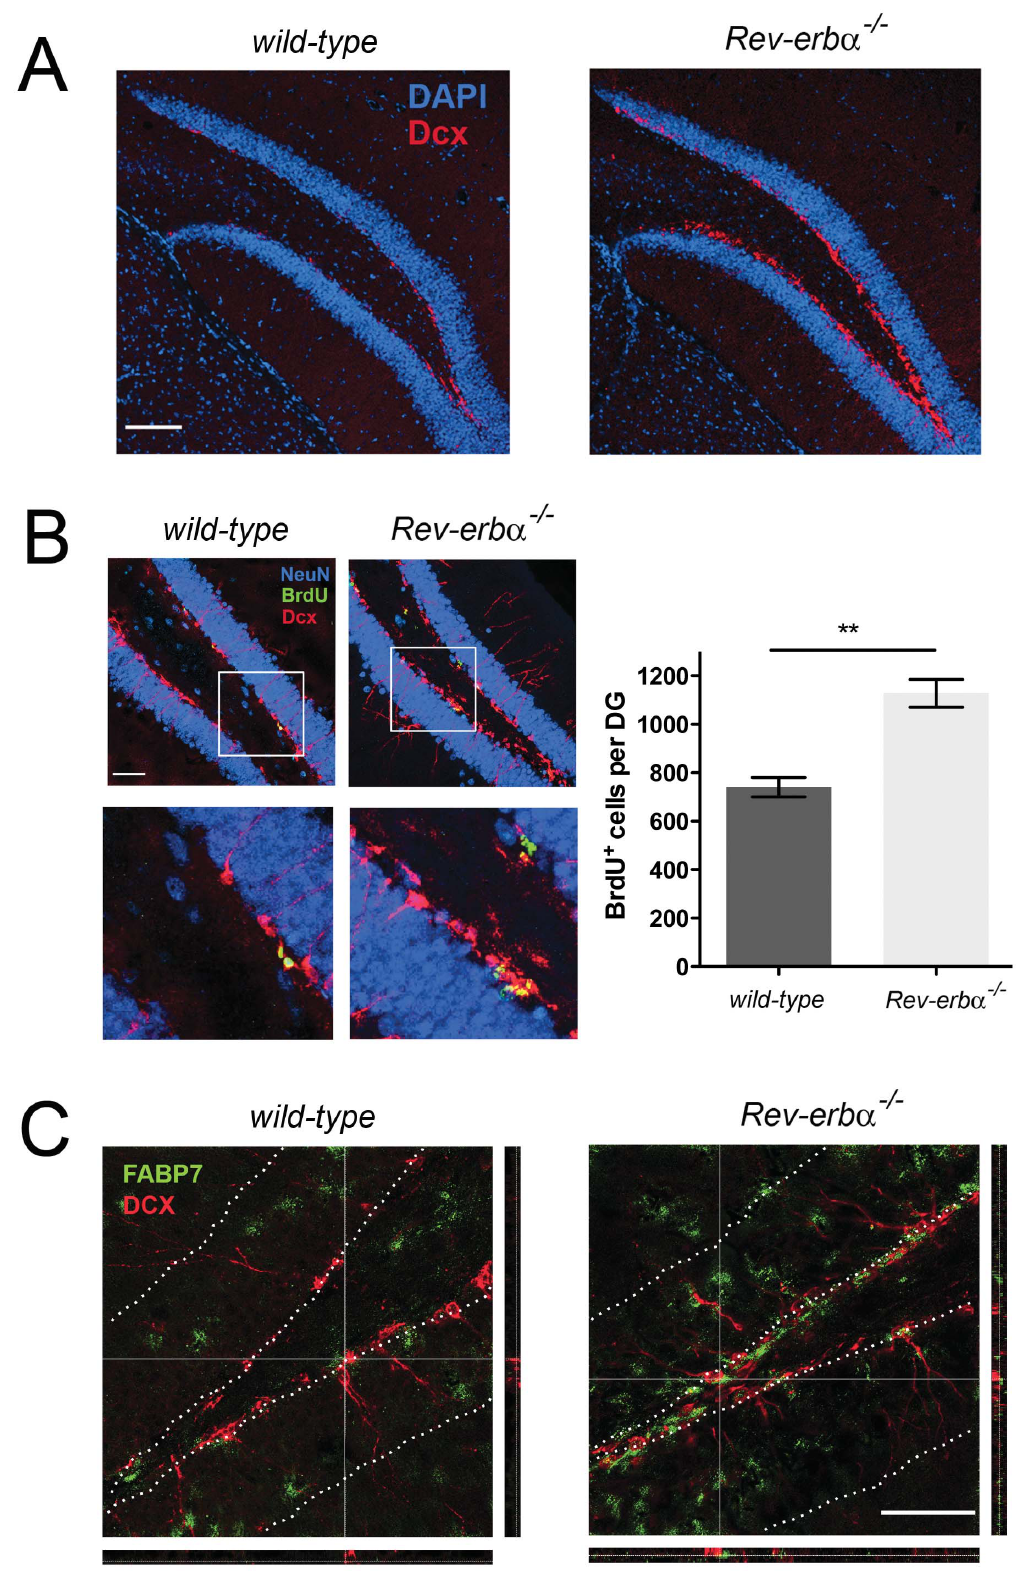
Figure 5. Immunohistochemistry in the dentate gyrus (DG) of wild-type and Rev-erb a 2 / 2 mice at ZT6. ( A ) Cell nuclei stained with DAPI are in blue and antibodies recognizing doublecortin (Dcx) are in red. Dcx expression is increased in the subgranular zone of Rev-erb a 2 / 2 mice indicating the presence of more neuroblasts in these animals. Scale bar: 100 m m. ( B ) Left panel: Visualization of cell division using bromodeoxyuridine